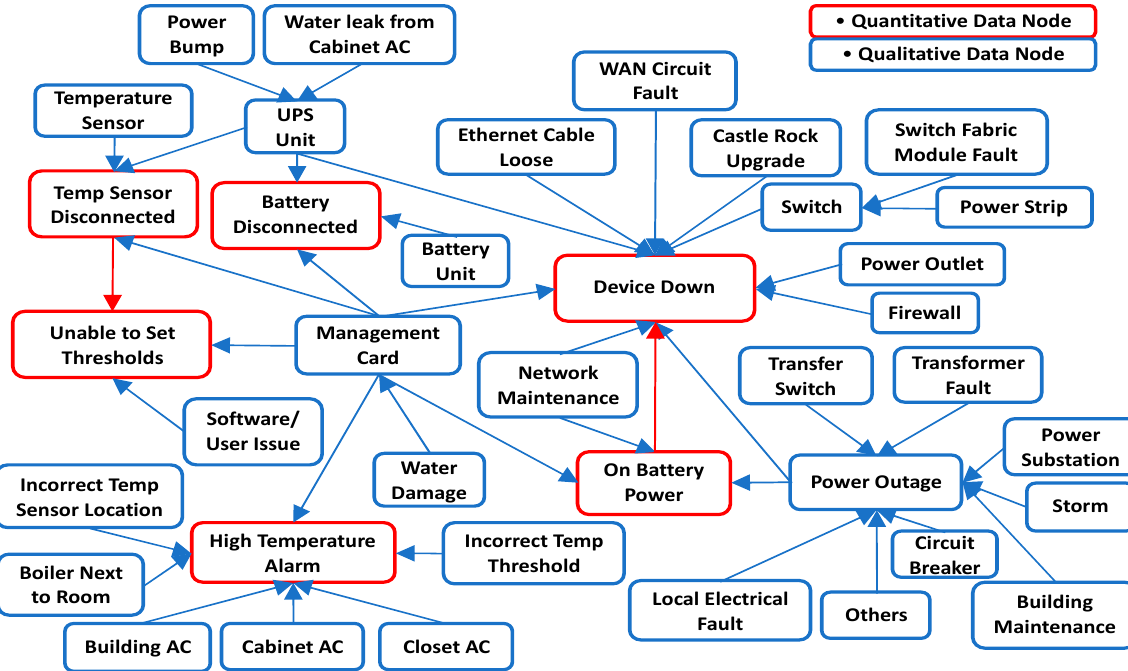
Figure 8. Fused Bayesian Network structure for top six occurring UPS messages.